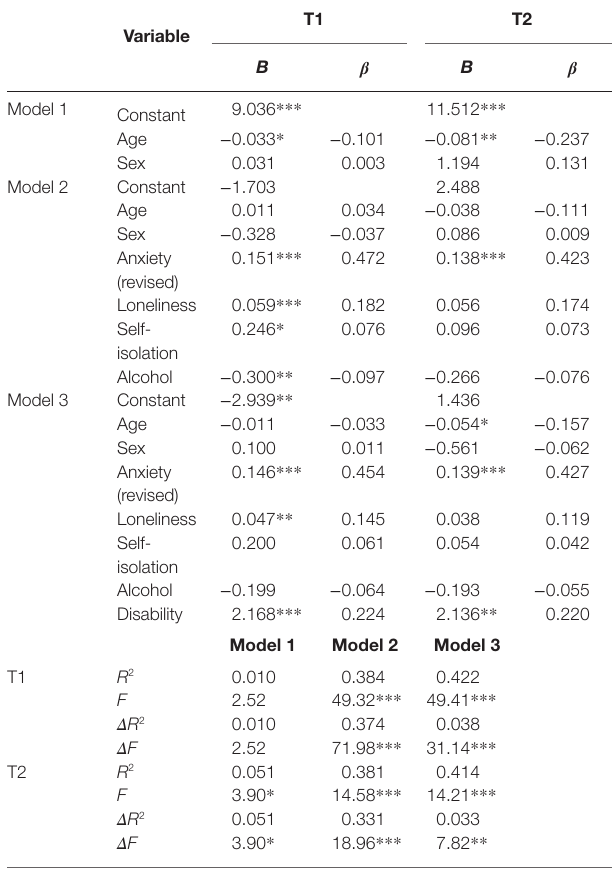
TABLE 6 | Hierarchical multiple regressions for PSQI sleep quality.